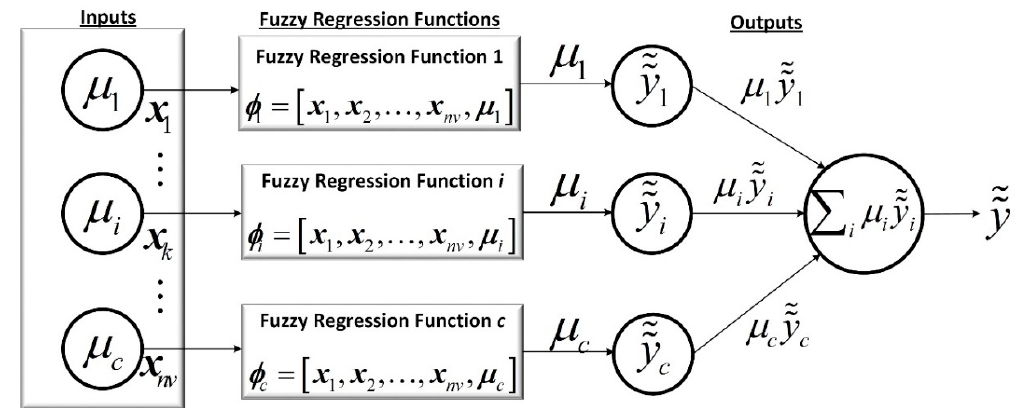
Figure 3. Proposed IT2F functions approach.